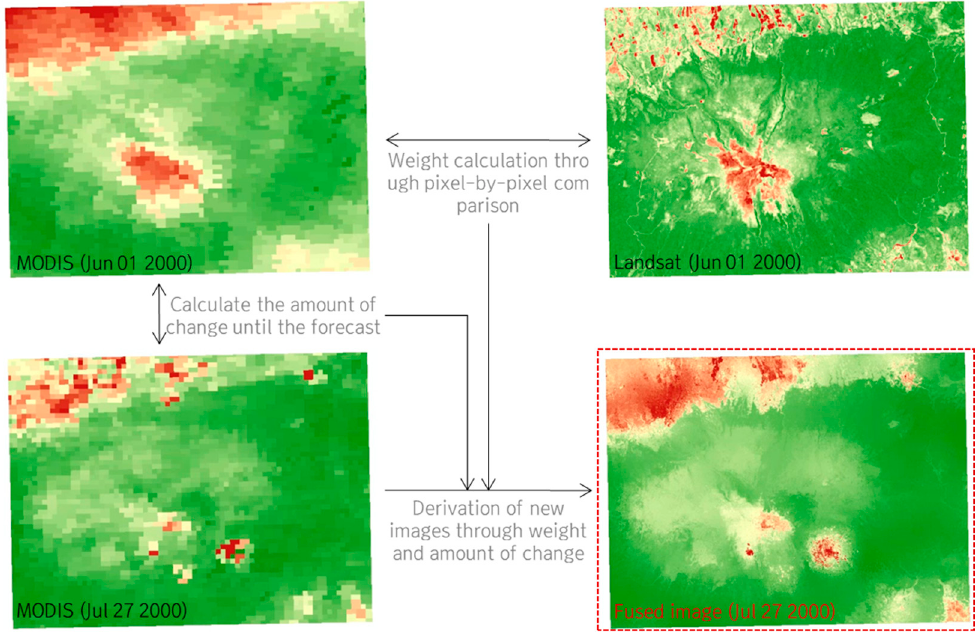
Figure 4. Example of image fusion results using the STARFM.